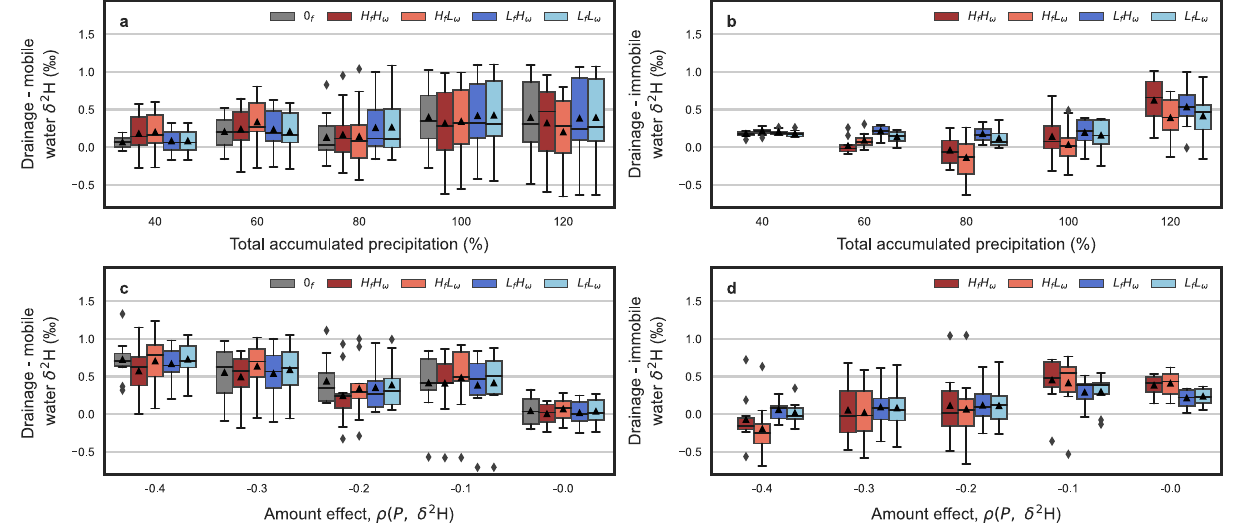
Fig. 4 | The in fl uence of climate parameters on isotope separation. The effect acrossmodelsimulationsofvaryingthetotalinputprecipitationontheaverage δ 2 H difference between drainage and a mobile or b immobile soil water as well as the in fl uence of varying the amount effect ’ s negative correlation represented by the Pearson correlation coef fi cient, ρ , between precipitation amount, P , and its δ 2 H composition on the average δ 2 H difference between drainage and c mobile or d immobile soil water. Precipitation is shown as a percent of the baseline amount